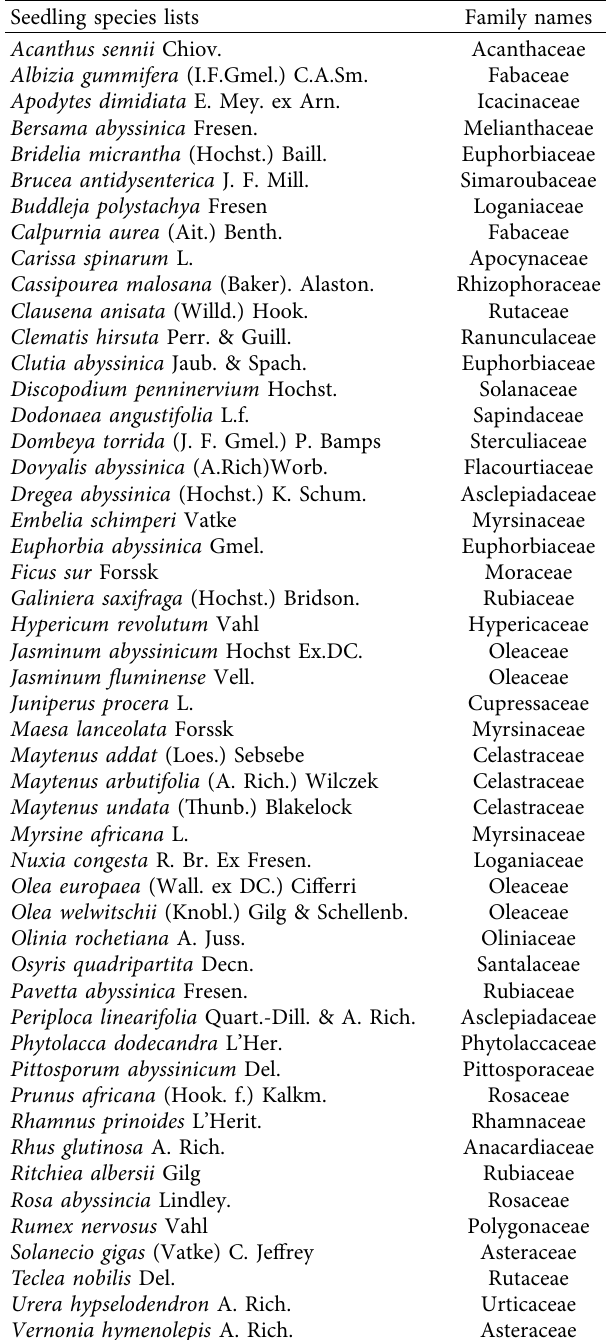
Table 10: List of seedling species.